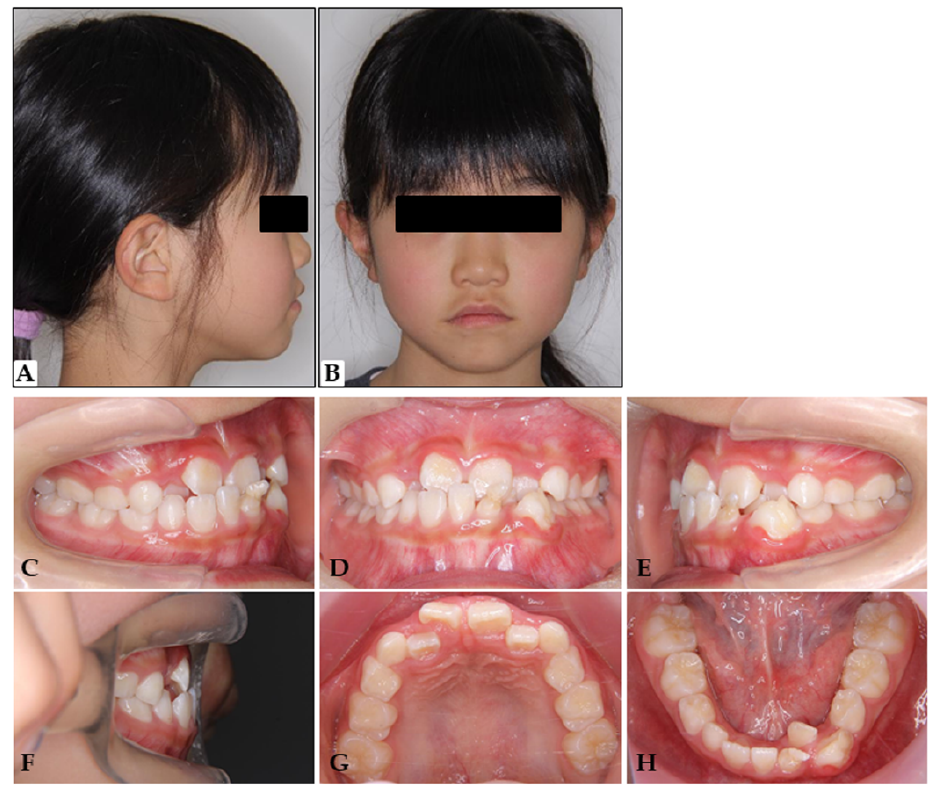
Figure 1. Pretreatment facial and intraoral photographs. ( A ) Lateral view; ( B ) frontal view; ( C ) right molar relationship; ( D ) centric occlusion; ( E ) left molar relationship; ( F ) overjet; ( G ) mirror view (maxillary); ( H ) mirror view (mandibular).